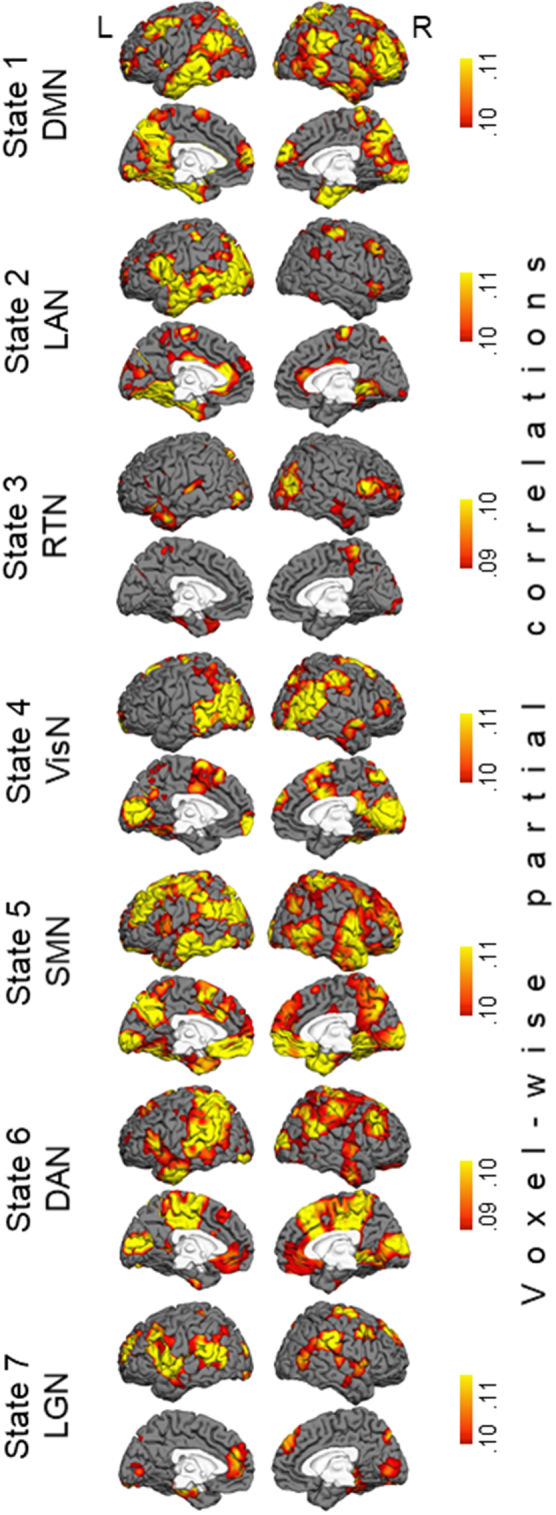
Voxel-wise maps of temporal coupling between the ultra-slow (<0.1 Hz) electrophysiological oscillations and the long timescale structure of seven salient HMM states in the CH group. Long timescale fluctuations in the rate of occurrence of each HMM state over time were quantified as changes in the proportion of time spent in the state within 5-sec-long (half-cycle length in 0.1 Hz oscillation) sliding windows. Each map shows the absolute values of partial correlations between the long timescale state time-course and the ultra-slow electrophysiological fluctuations in individual brain voxels. These effects were significantly lower in the control analysis with equalized state lifetimes (p < 0.05, corrected; note, Van de Ville et al., 2010 showed that equalizing state durations removed long-range dependencies in the electrophysiological data). Abbreviations are the same as in Fig. 2.